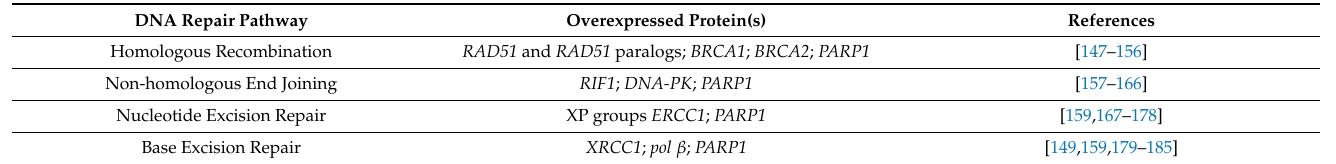
Table 1. Summary of DNA Damage and Repair Proteins Overexpressed in Ovarian